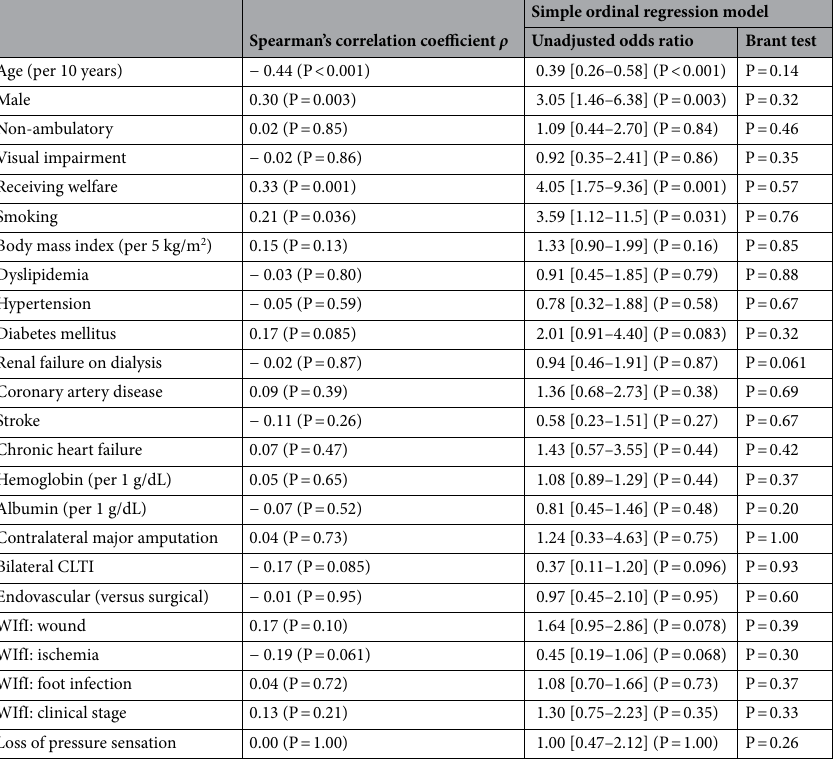
Table 3. Crude association of clinical characteristics with lower frequency of meeting with a trusted family member or friend in a subgroup who lived alone ( n = 101). Odds ratios, derived from the ordinal regression analysis, are presented together with 95% confidence intervals. CLTI chronic limb-threatening ischemia, WIfI wound, ischemia, and foot infection.